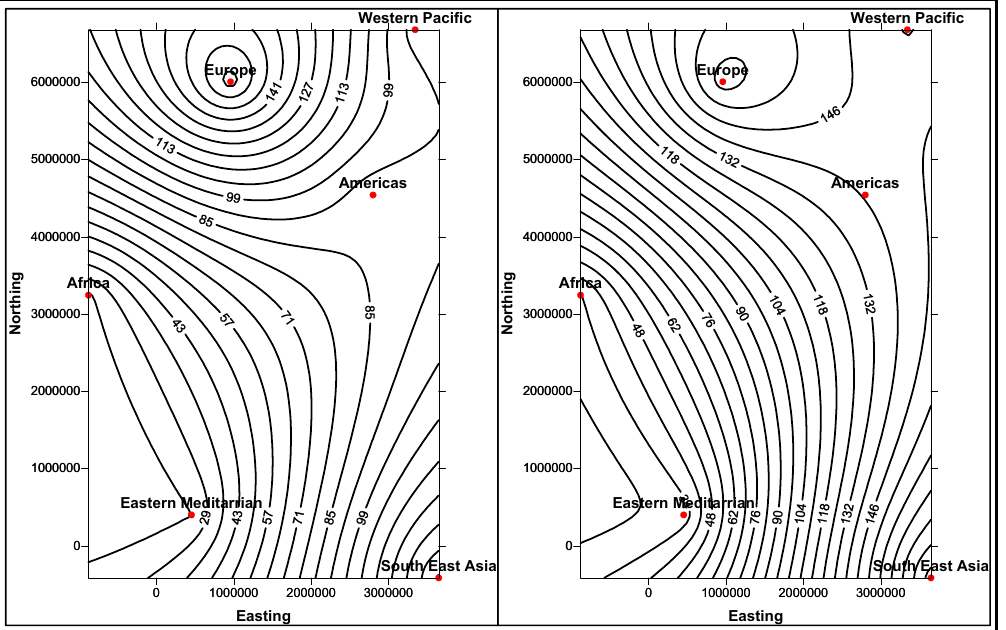
Figure 16. Map views for different regions showing diabetes deaths (more than 65 age group of male and female, in thousands).